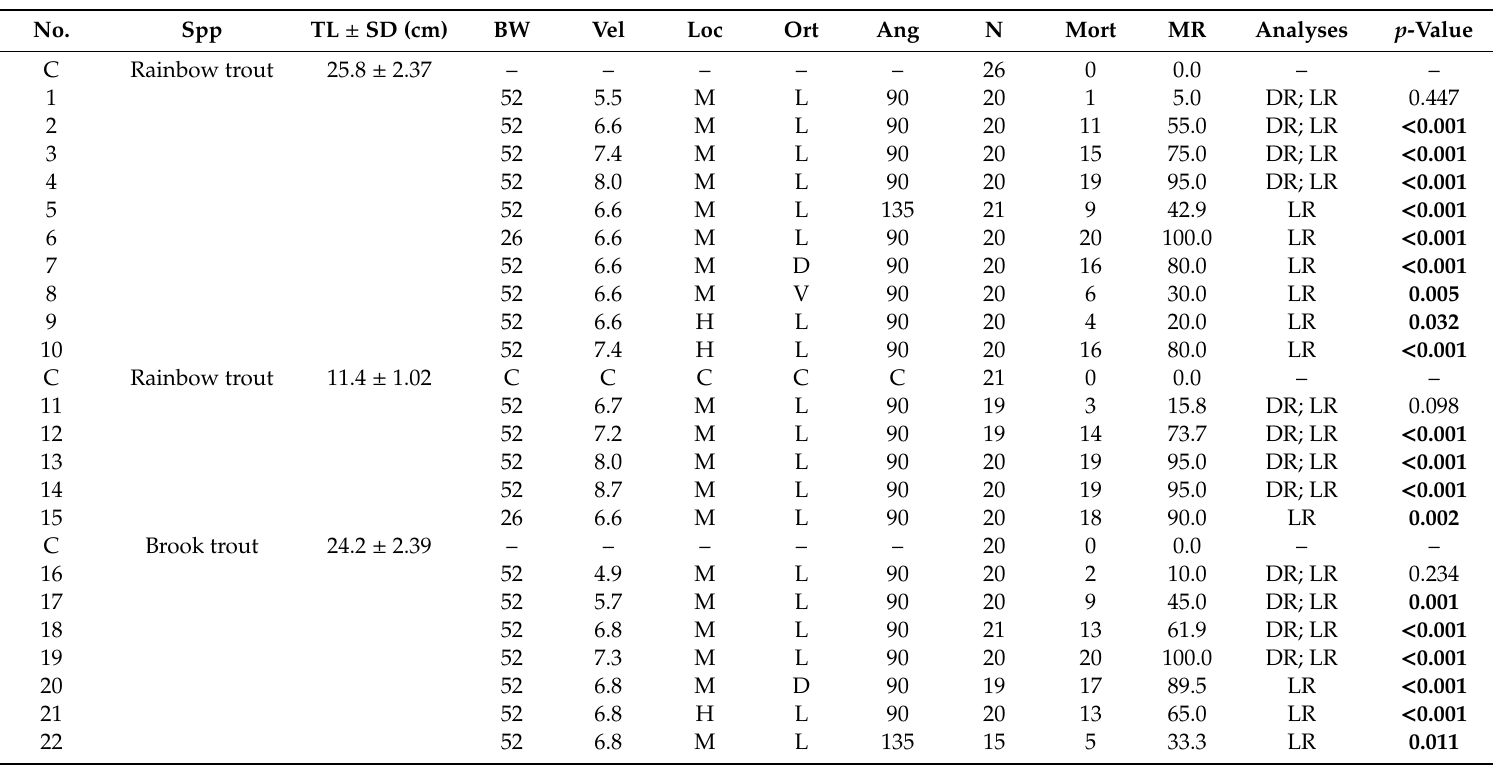
Table A1. Experimental overview of the study including 34 treatment groups and five control (C) groups for rainbow trout (large and small), brook trout, gizzard shad, and Alosa spp. (species data combined because sample sizes of American shad and blueback herring were small. Mean total length (TL) is reported with standard deviation (SD) with units of centimeter (cm). Blade strike characteristics included blade width (BW; mm), velocity (Vel; m / s), location (Loc, with M; mid-body or H; head), orientation (Ort, with L; lateral, D; dorsal, and V; ventral), impact angle (Ang). The total number in each group (N) is reported with counts (Mort) and rates (MR) of mortalities. Analyses include dose–response (DR) and logistic regression (LR) used in this study. P-values are calculated for Chi-square tests with Yates | ad − bc |− 0.5 N ) 2 N = ( correction using the following equation [1]: χ 2 and compared each treatment to the species’ control group. We assumed α = 0.05; significant mnrs Yates comparisons are in